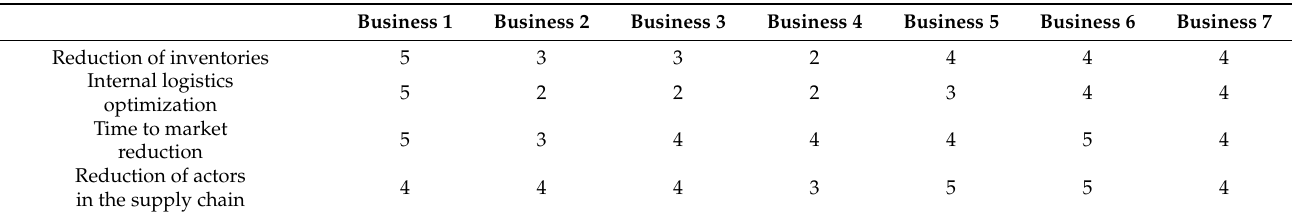
Table 5. Companies’ perception on the impact of the use of 3D printers in the medical sector at a supply chain level.